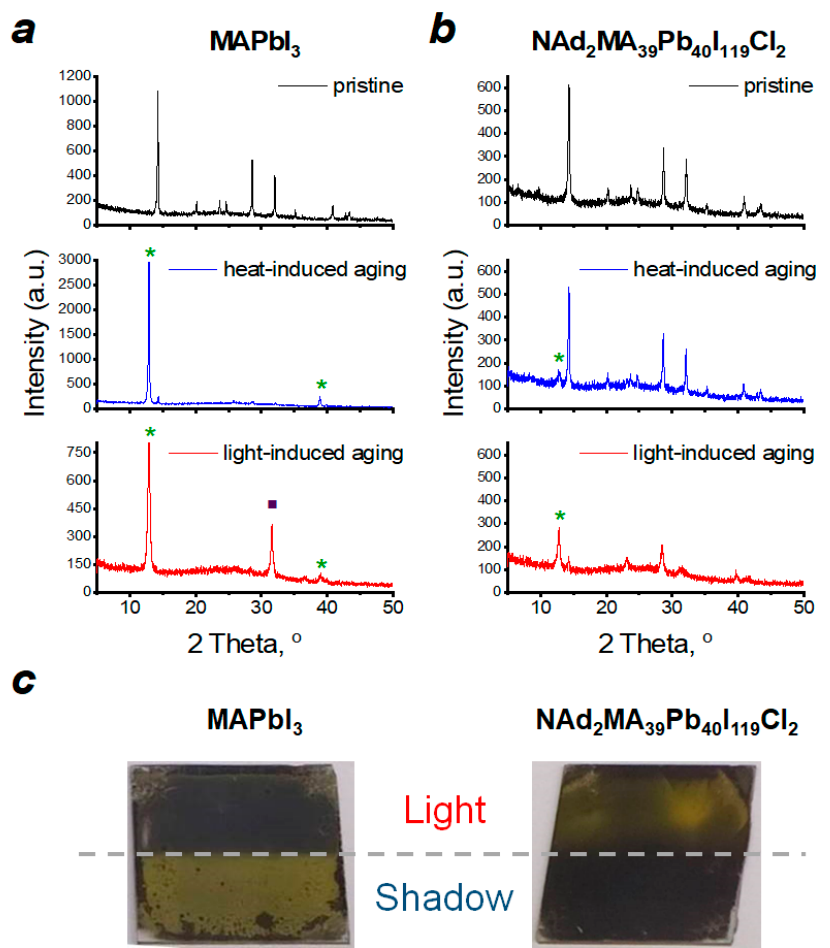
Figure 3. The XRD patterns of the pristine and the thermally and photochemically aged samples of ( a ) MAPbI 3 and ( b ) NAd 2 MA 39 Pb 40 I 119 Cl 2 ; the peaks of PbI 2 are indicated by “*”, and the peaks of Pb 0 are marked with “ (cid:4) ”. ( c ) The visual appearance of the samples exposed to light or heat (shaded part) after 1400 h of continuous aging.